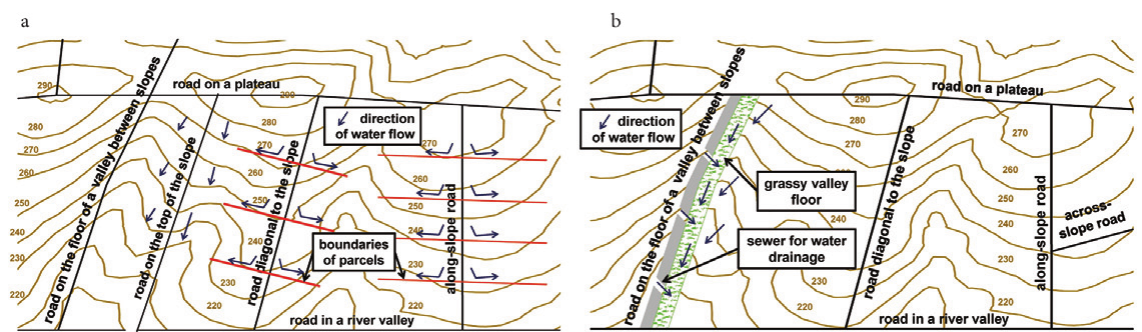
Fig. 1. Proposals for the location of rural roads in an area with diverse land relief: a – roads along and diagonal to the slope; b – road in the valley between